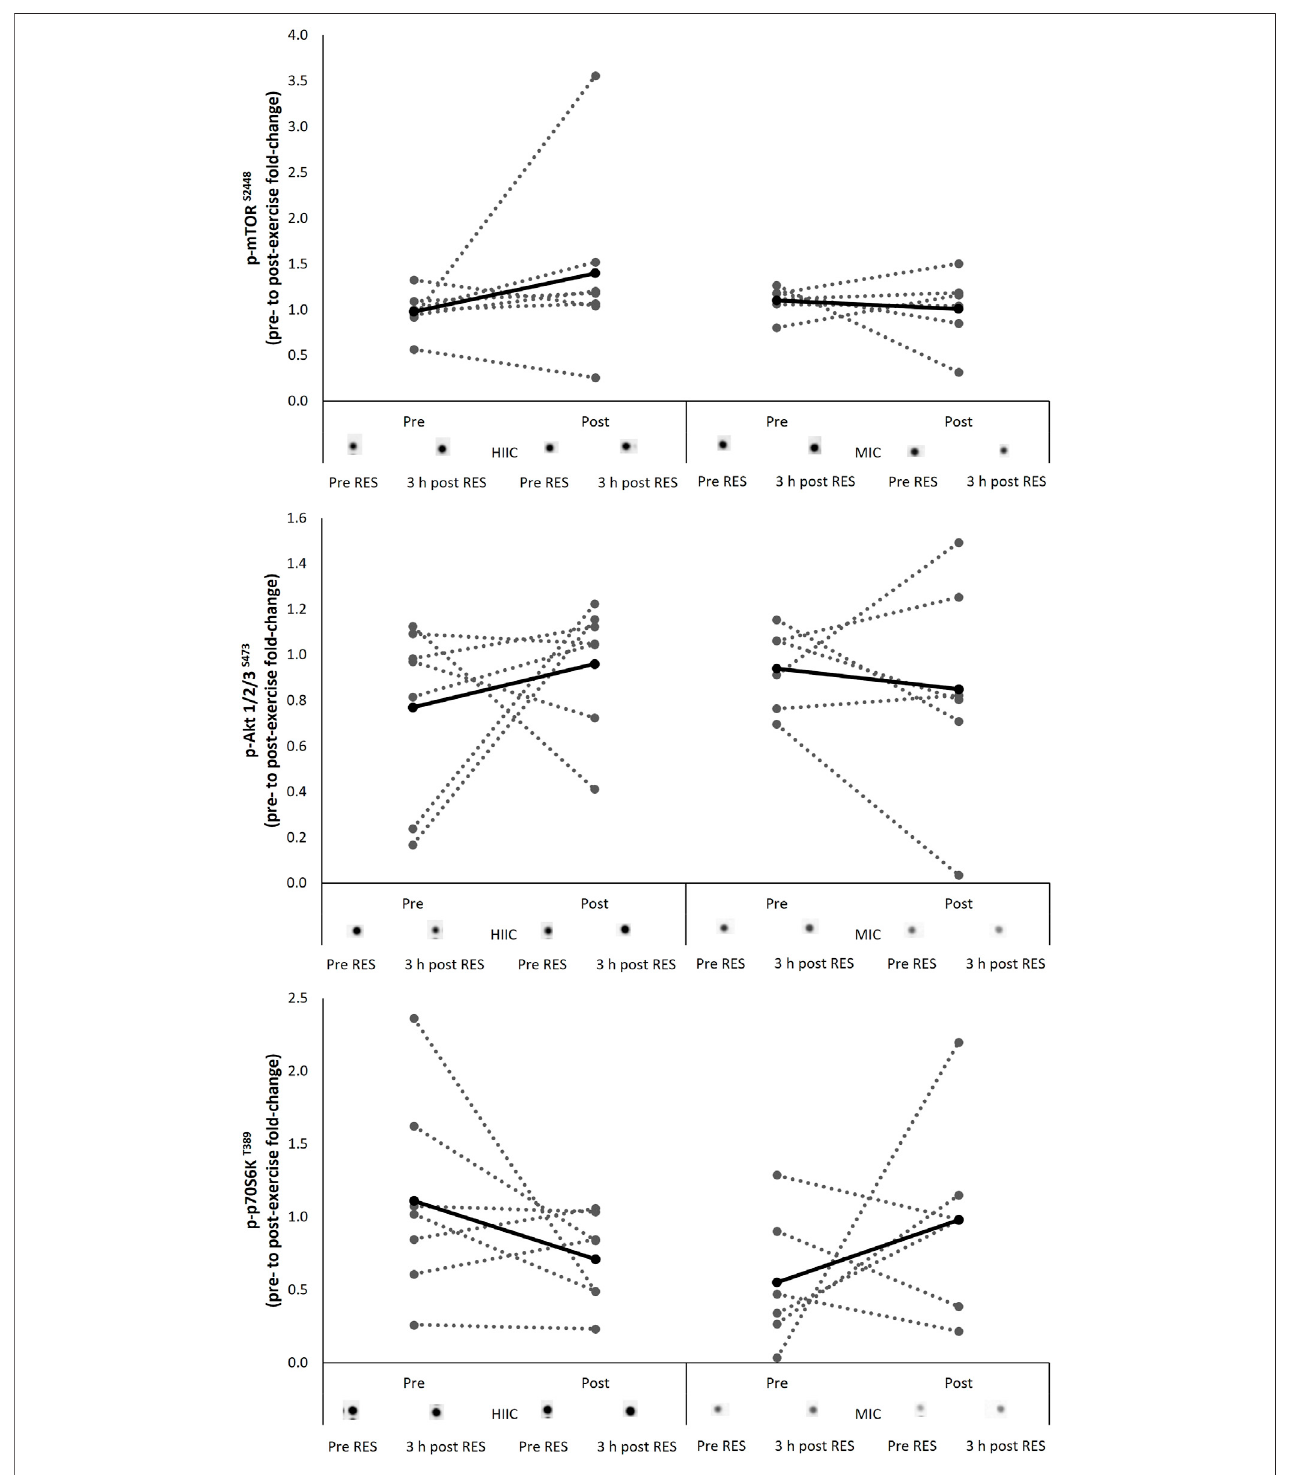
FIGURE 5 | Individual (dashed lines and grey dots) and mean (black lines and black dots) (A) CMJ height and (B) 5 min TT performance at pre- and post- intervention in the MICT ( n = 6) and HIIT ( n = 7) groups. MICT = moderate intensity cycling; HIIT = high intensity interval cycling. *, signi fi cantly different from pre-to post- intervention ( p <